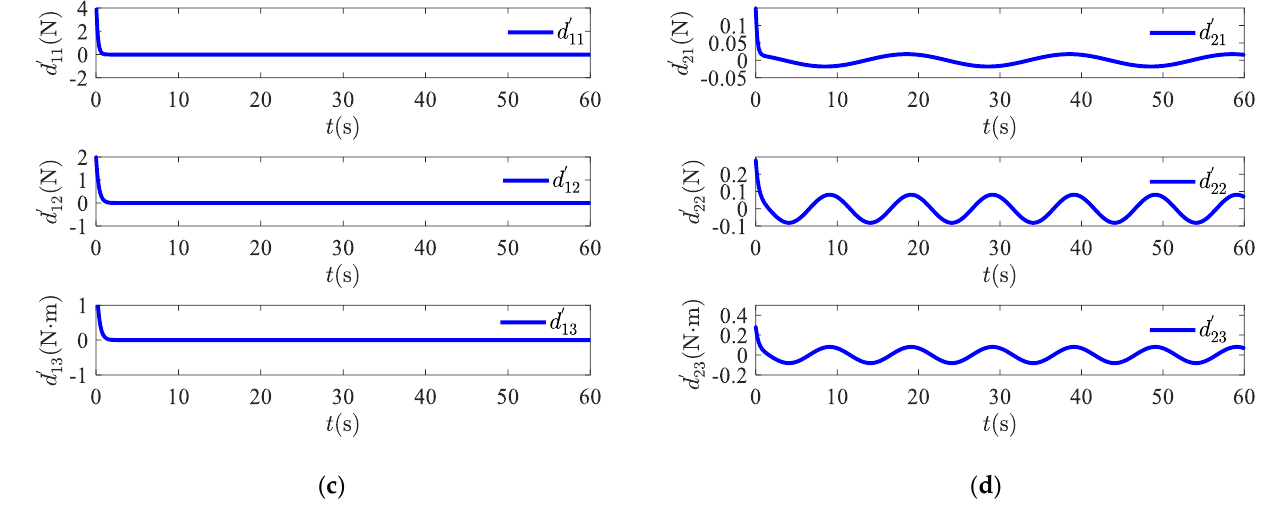
Figure 3. Disturbance observer simulation results: ( a ) actual values and observed values for constant disturbances; ( b ) actual values and observed values for time-varying disturbances; ( c ) constant disturbance errors; ( d ) time-varying disturbance errors.